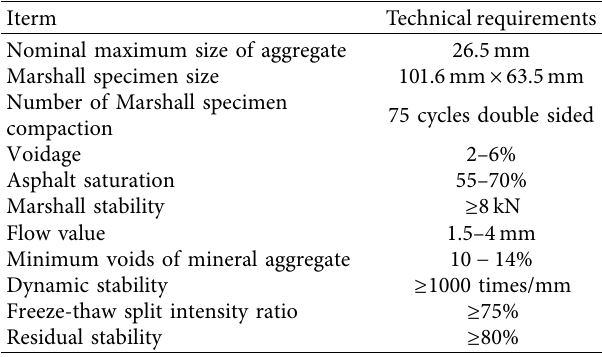
Figure 3: The RAM of different proportions of bricks to concrete. (a) RBA : RCA � 0 :10. (b) RBA : RCA � 2 : 8. (c) RBA : RCA � 4 : 6. (d) RBA : RCA � 6 : 4. Table 3: Technical requirements for dense gradation base (ATB-25) asphalt